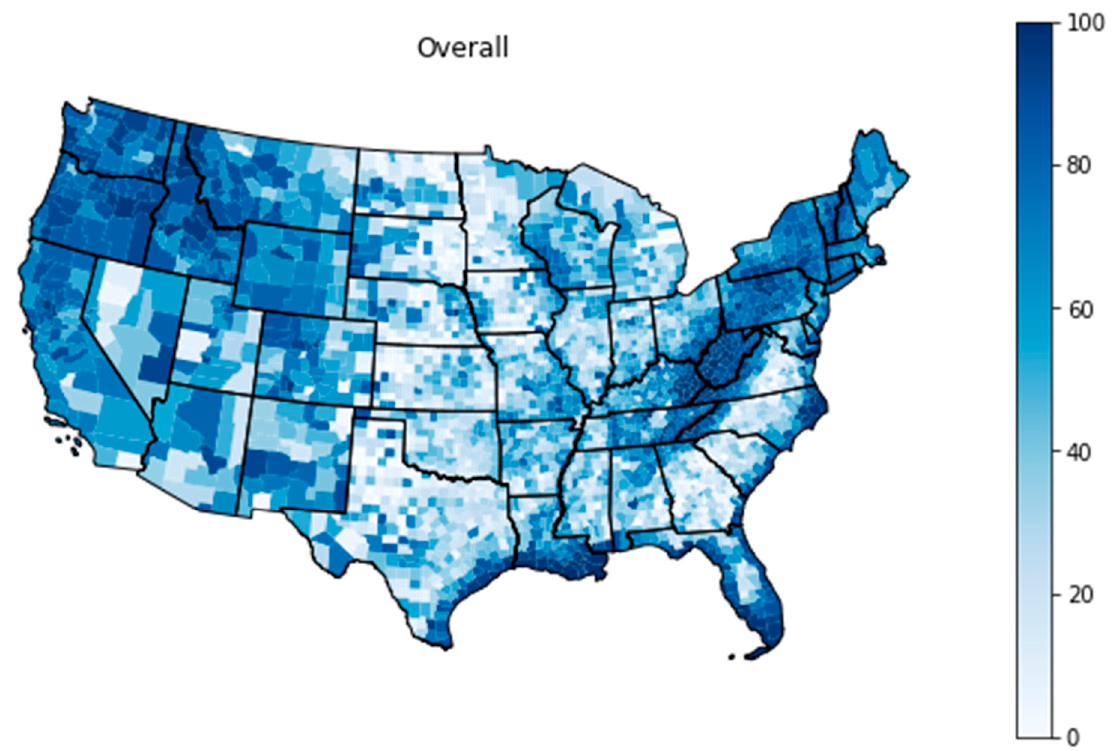
Figure 2. Overall risk by county (percent of infrastructure with operational risk).